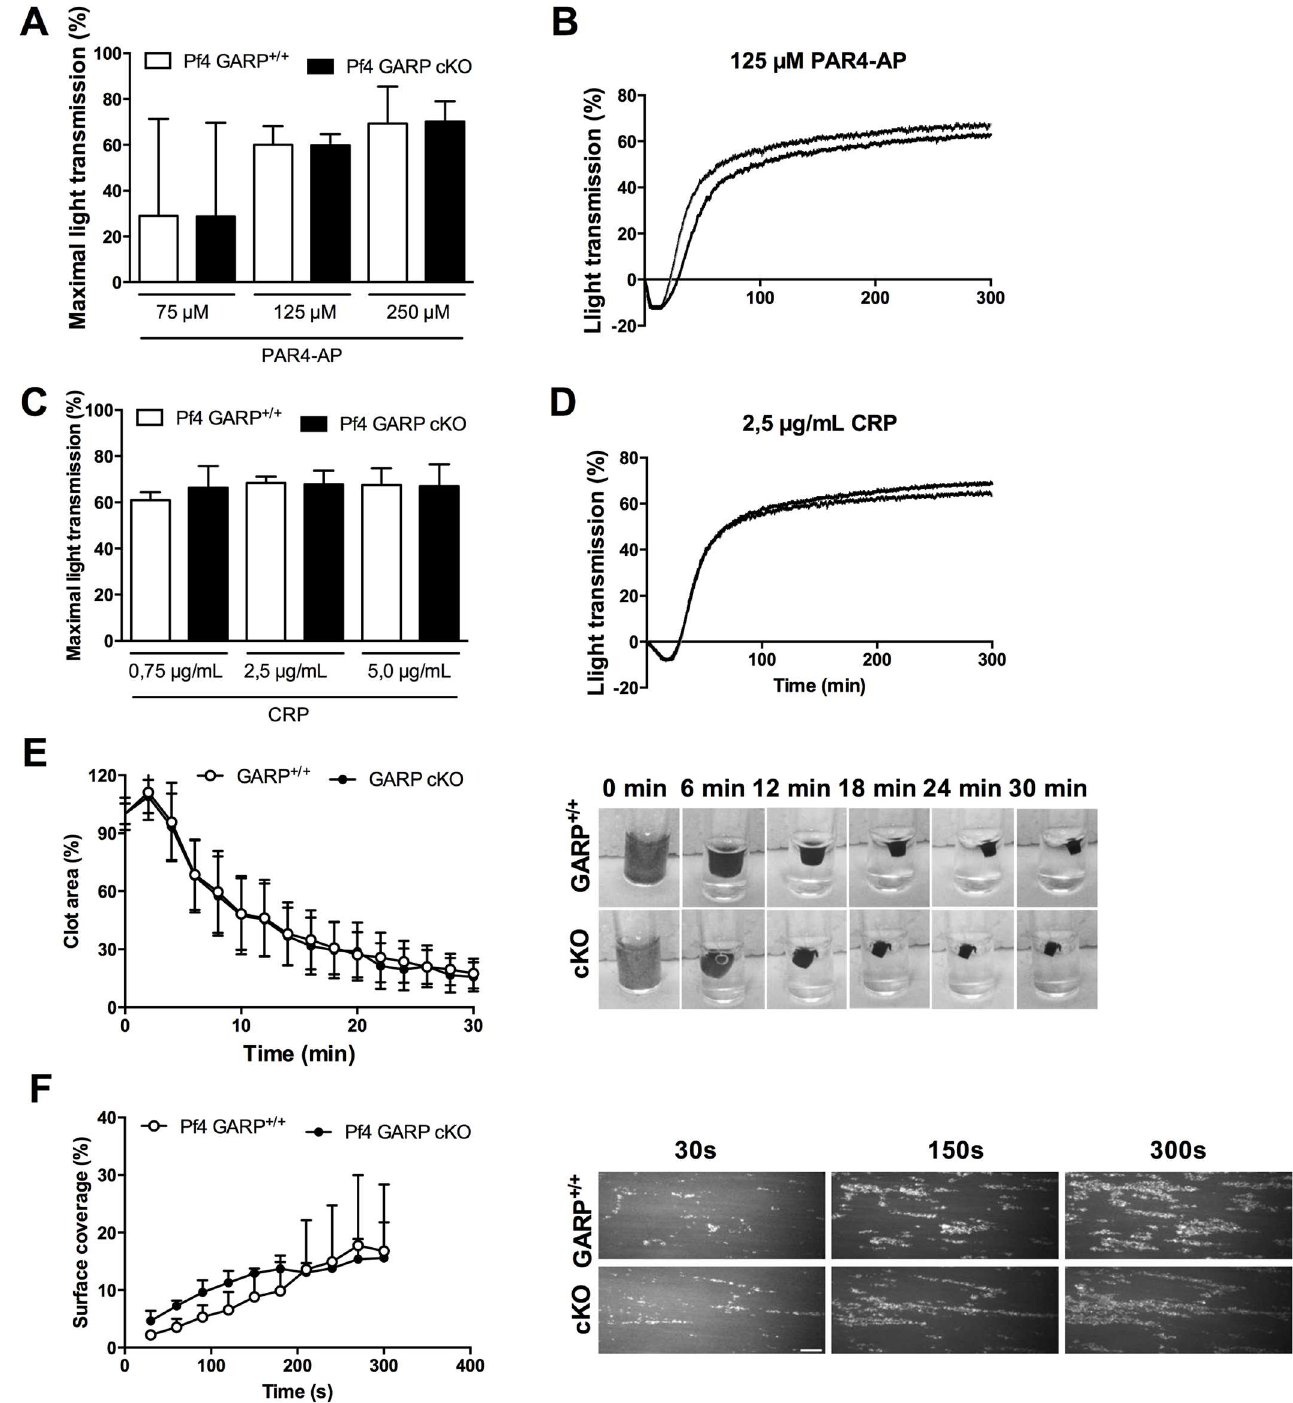
Fig 3. GARP deficiency in platelets does not affect platelet aggregation. Aggregation was inducedin PRP of GARP +/+ and GARP cKO mice using 75, 125 or 250 μ M PAR4-AP ( A ) and 0.75, 2.5 or 5 μ g/mL CRP ( C ). Maximal light transmissionwas calculatedand graphed of at least 3 individual experiments. Representative curves for 125 μ M PAR4-AP ( B ) and 2.5 μ g/mL CRP ( D ) inducedaggregations in GARP +/+ (grey) and GARP cKO (black) are shown. ( E ) Clot retraction of PRP supplemented with erythrocytes was inducedusing 5 U/mL thrombin and 20 mM CaCl 2 in GARP +/+ littermates and GARP cKO. Pictures were made every two minutes and clot area was analyzedusing ImageJ. Representative pictures are shown on the right. Measuredclot area is presented on the right; n = 3. ( F ) Whole blood of GARP cKO mice and GARP +/+ littermates was perfused over a Horm collagen(100 μ g/mL) coated coverslipat a shear rate of 1600s -1 . Thrombus formation was visualizedduring5 min and surface coveragewas quantified using ImageJ; n = 3. Representative pictures of thrombus formation under flow are shown on the right; scale bars represent50 μ m. doi:10.1371/journal.pone.0173329.g003 PLOS ONE | DOI:10.1371/journal.pone.0173329 March 9,